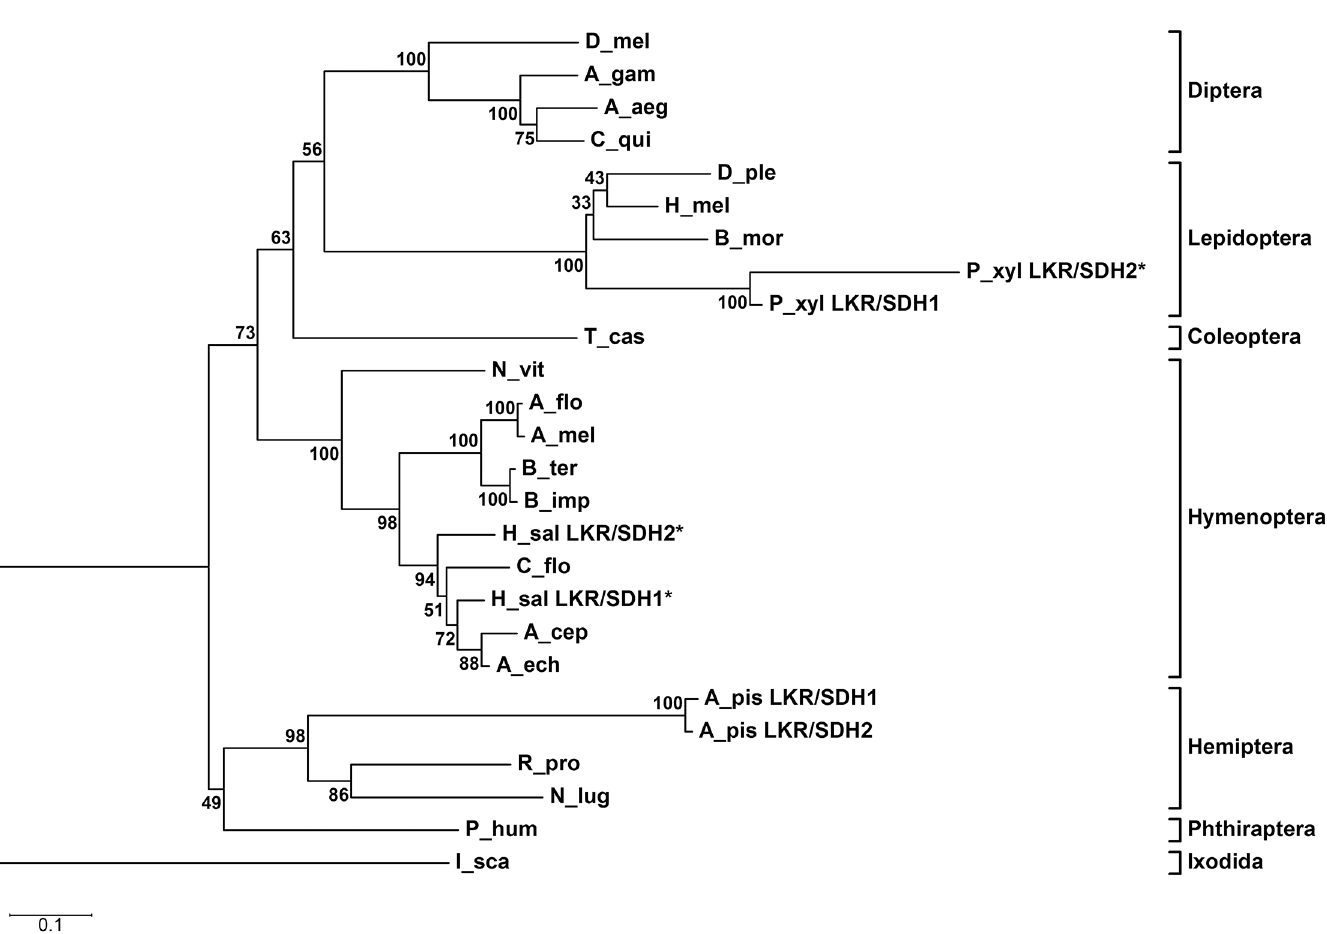
Fig 4. Phylogenic analysis of insect LKR/SDH. A rooted phylogenetic tree constructed by the maximum-likelihood method (the best-fitting model, LG+I+ γ , with empirical frequency) based on the protein sequence alignments. The LKR/SDH-like sequences originated from Ni . lugens (N_lug), Rhodnius prolixus (R_pro, RPTMP07240), Acyrthosiphon pisum (A_pis LKR/SDH1, ACYPI004937; A_pis LKR/SDH2, ACYPI065217), Pediculus humanus (P_hum, PHUM016080), Tribolium castaneum (T_cas, TC002311), Nasonia vitripennis (N_vit, Nasvi2EG008769), Acromyrmex echinatior (A_ech, AECH18409), Atta cephalotes (A_cep, ACEP10511), Camponotus floridanus (C_flo, CFLO20285), Harpegnathos saltator (H_sal LKR/SDH1, HSAL12725; H_sal LKR/SDH2, HSAL12725), Bombus impatiens (B_imp, XP_003487153), Bombus terrestris (B_ter, XP_003398633), Apis mellifera (A_mel, GB47970), Apis florea (A_flo, XP_003692916), Aedes aegypti (A_aeg, AAEL014734), Anopheles gambiae (A_gam, AGAP008632), Culex quinquefasciatus (C_qui, CPIJ000416), Drosophila melanogaster (D_mel, FBgn0025687), Bombyx mori (B_mor, BGIBMGA010338), Heliconius melpomene (H_mel, HMEL016438), Plutella xylostella (P_xyl LKR/SDH1, Px002140; P_xyl LKR/SDH2, Px002187) and Danaus plexippus (D_ple, DPOGS208487).The LKR/SDH from Ixodes scapularis (I_sca, ISCW008489) was added as an outgroup. The percentiles of bootstrap values (1,000 replicates) are indicated. The scale bar represents the amino acid divergence. The pseudogenes are marked with